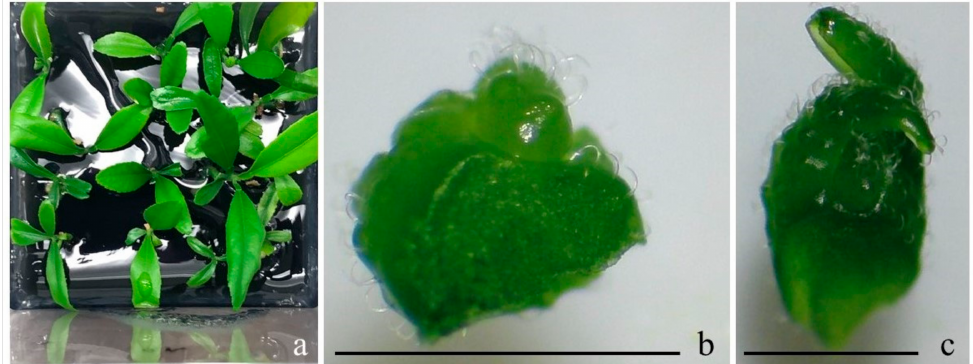
Figure 1. The micro-shoots and shoot tips of Citrus spp. used in experiments. The micro-shoots of C. deliciosa cv. “Bodrum Mandarin” derived from in vitro clonal propagiton ( a ), the shoot tips in different sizes derived from micro-shoots of C. nobilis cv. “Klin Mandarin” ( b , c ), bars 1